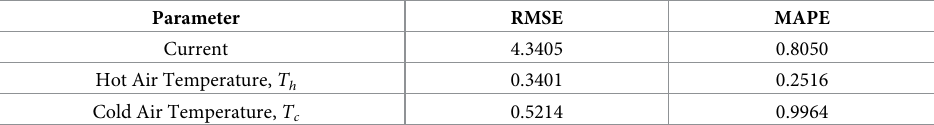
Table 7. Results analysis from the combined